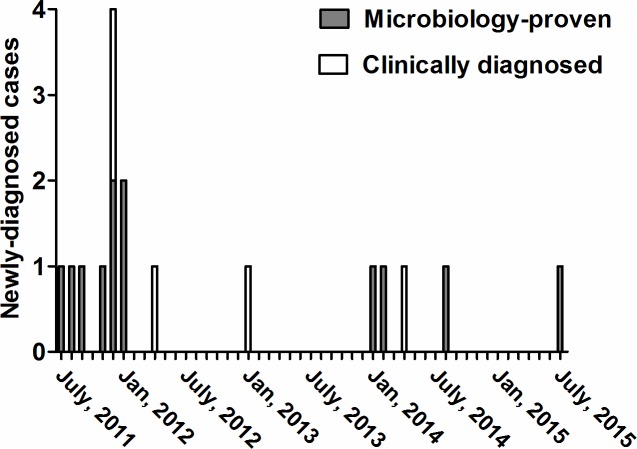
Epidemic curve of the reported TB outbreak.